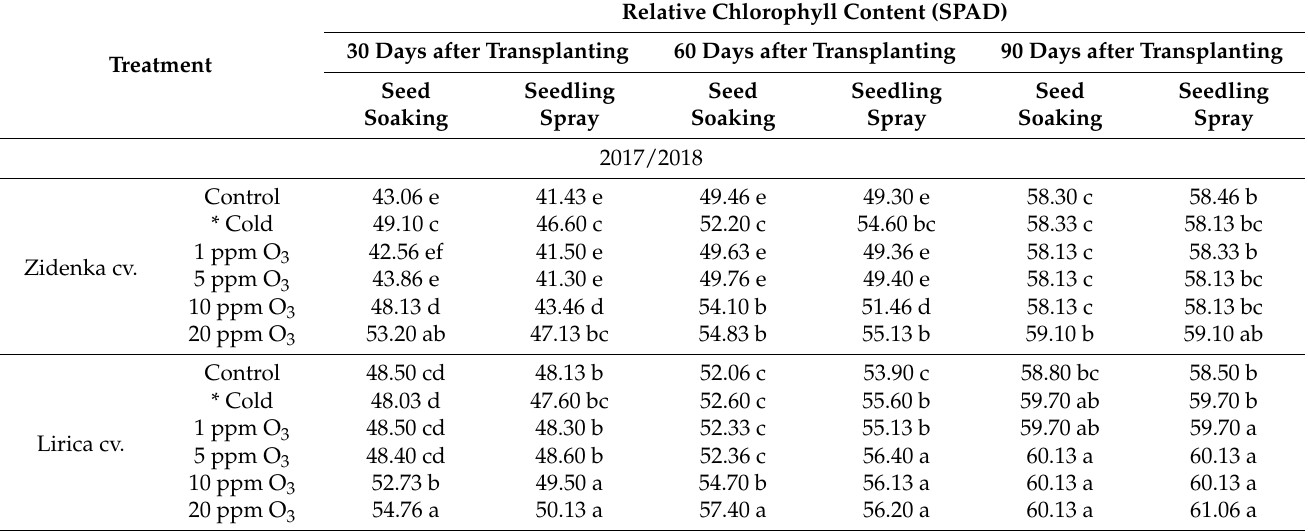
Table 3. Effect of ozone and chilling tolerance pretreatments on relative chlorophyll content (SPAD) of two sweet pepper hybrids 30, 60, and 90 days after transplanting during the 2017/18 and 2018/19